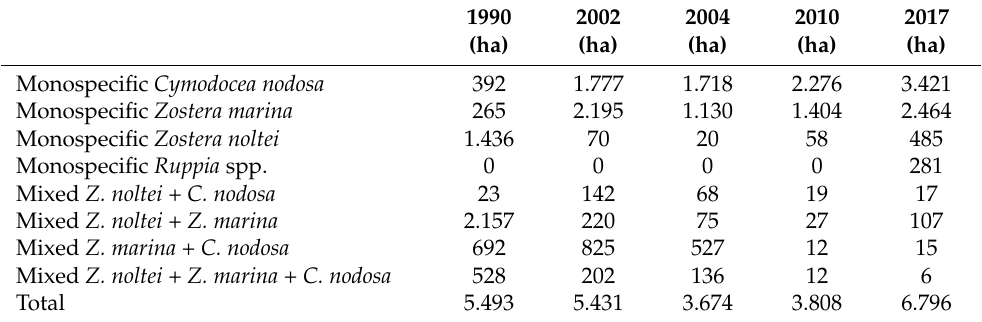
Table 2. Seagrass coverage reported for Venice lagoon in 1990, 2002, 2004, 2010